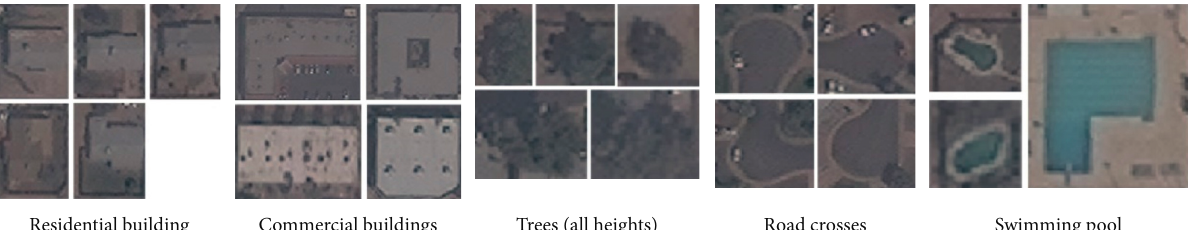
Figure 5: Visual illustration on (a) experimental dataset 1, and (b) experimental dataset